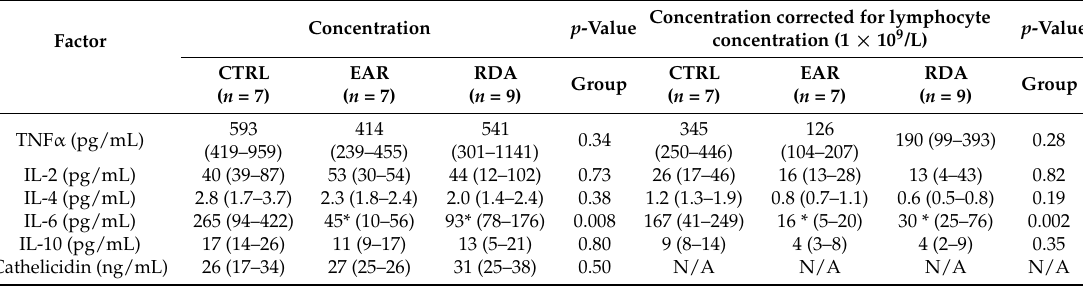
Table 5. Cytokine production by peripheral blood mononuclear cells after stimulation with Con A and cathelicidin concentration from plasma in 6–8 years old subset at 12